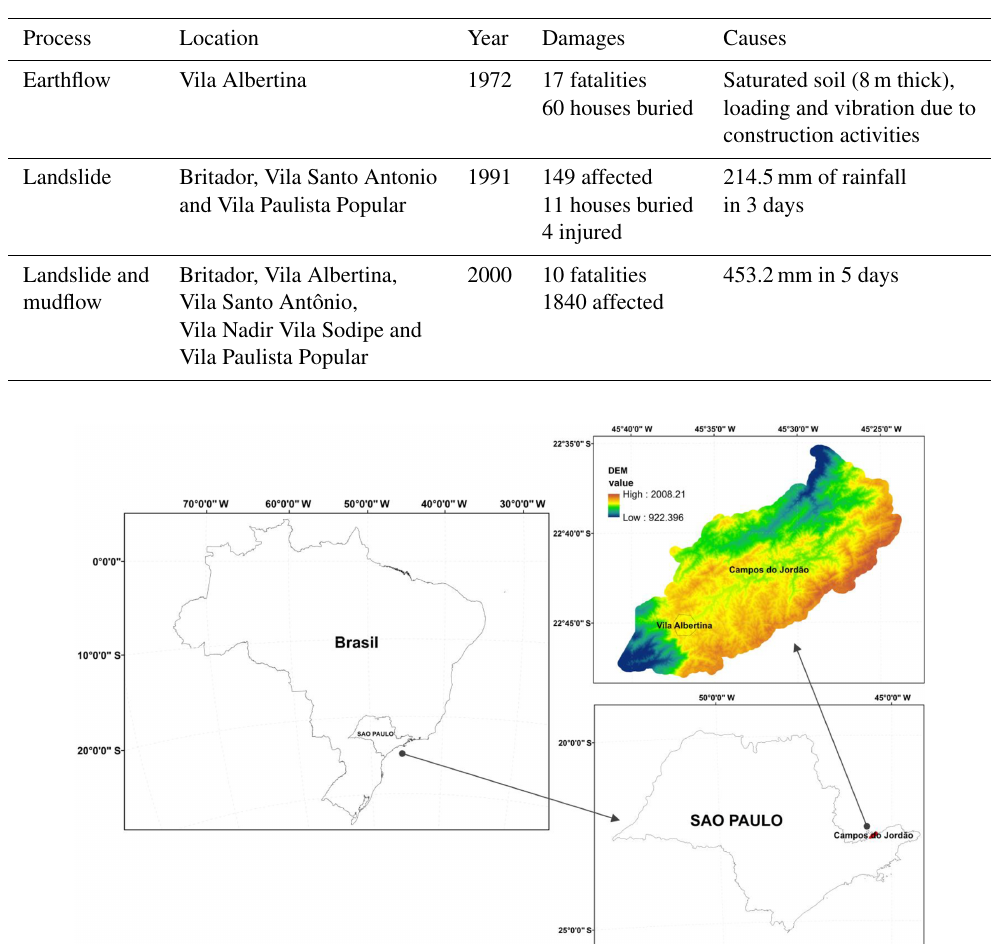
Figure 1. Geographical location of the Campos do Jordão municipality and an inset of the study site.